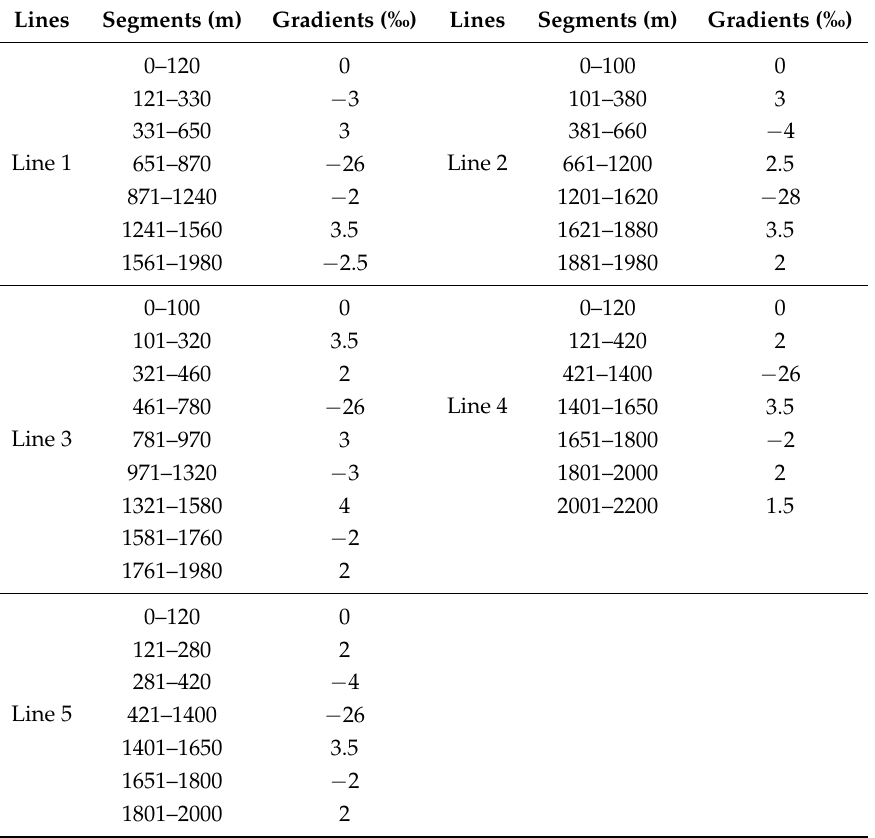
Table 4. Gradient information of different